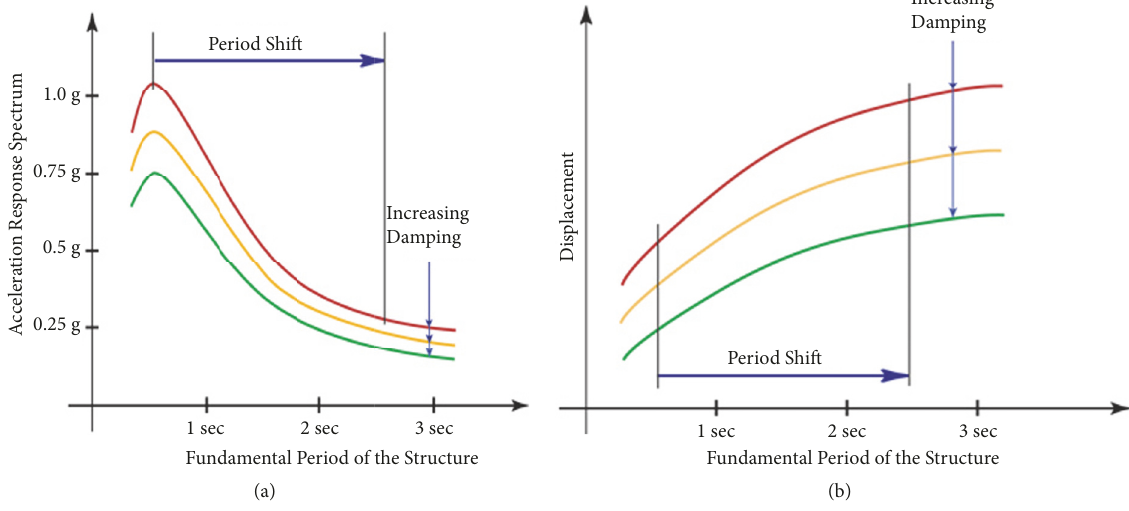
Figure 2: Plots illustrating isolators’ performances (effects of lengthening of structure